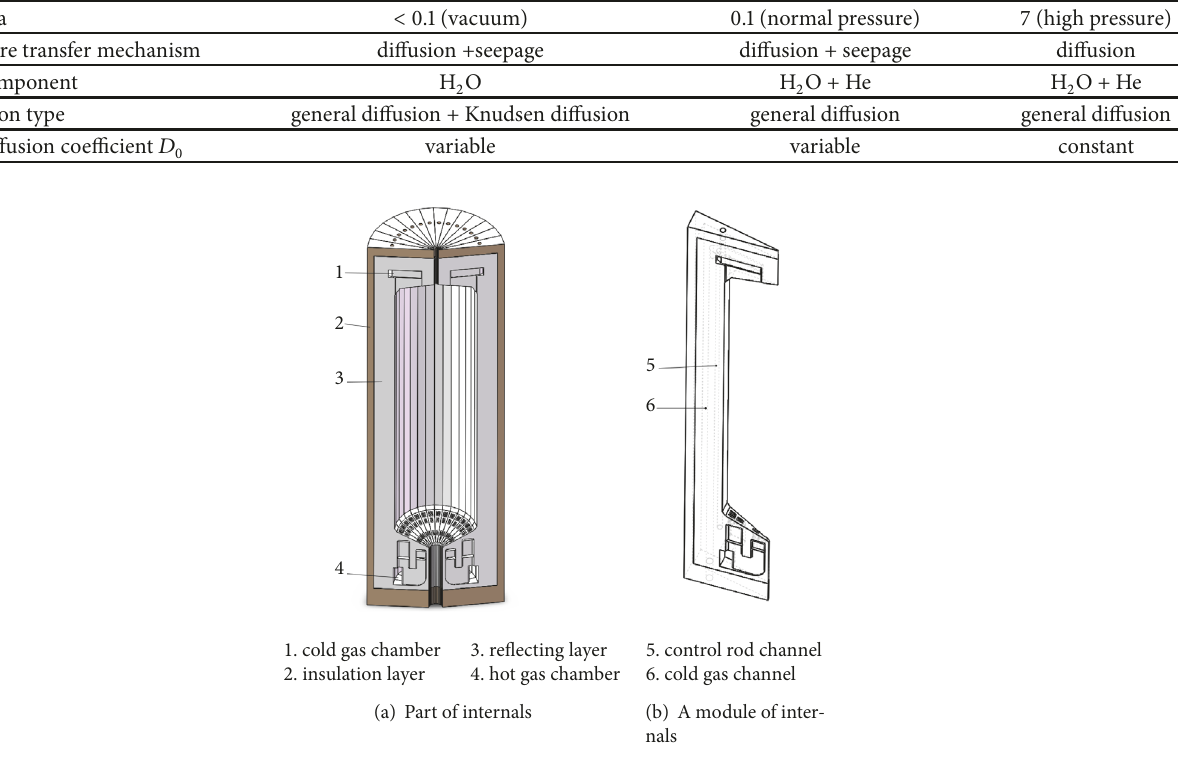
Figure 2: Internals in HTR-PM